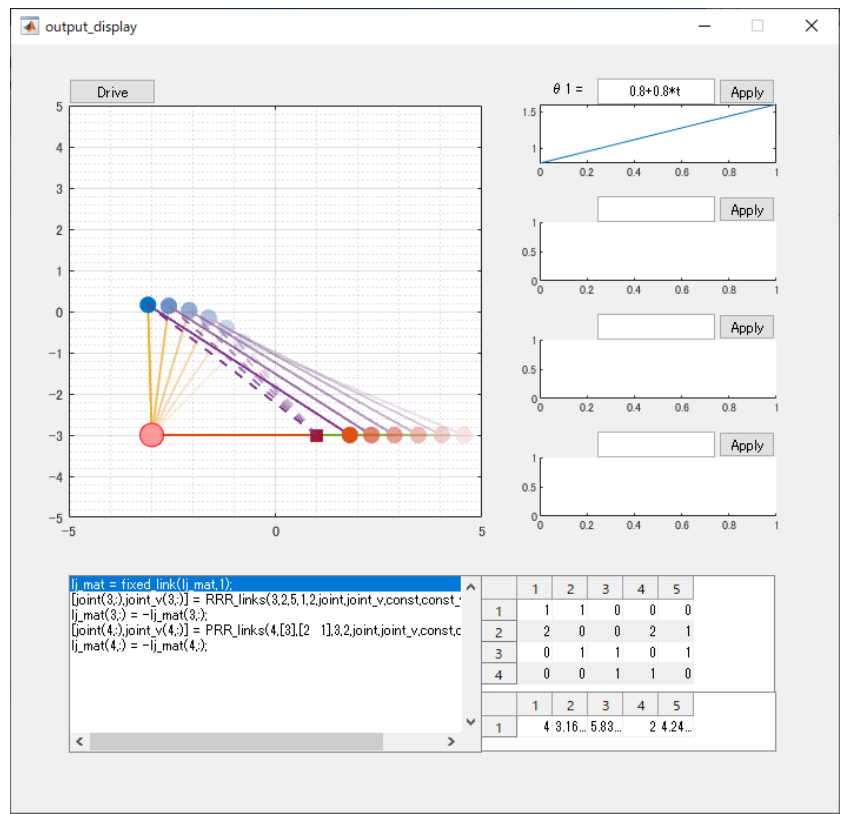
Figure 13. The motion simulation of slider-crank mechanism according to the extracted